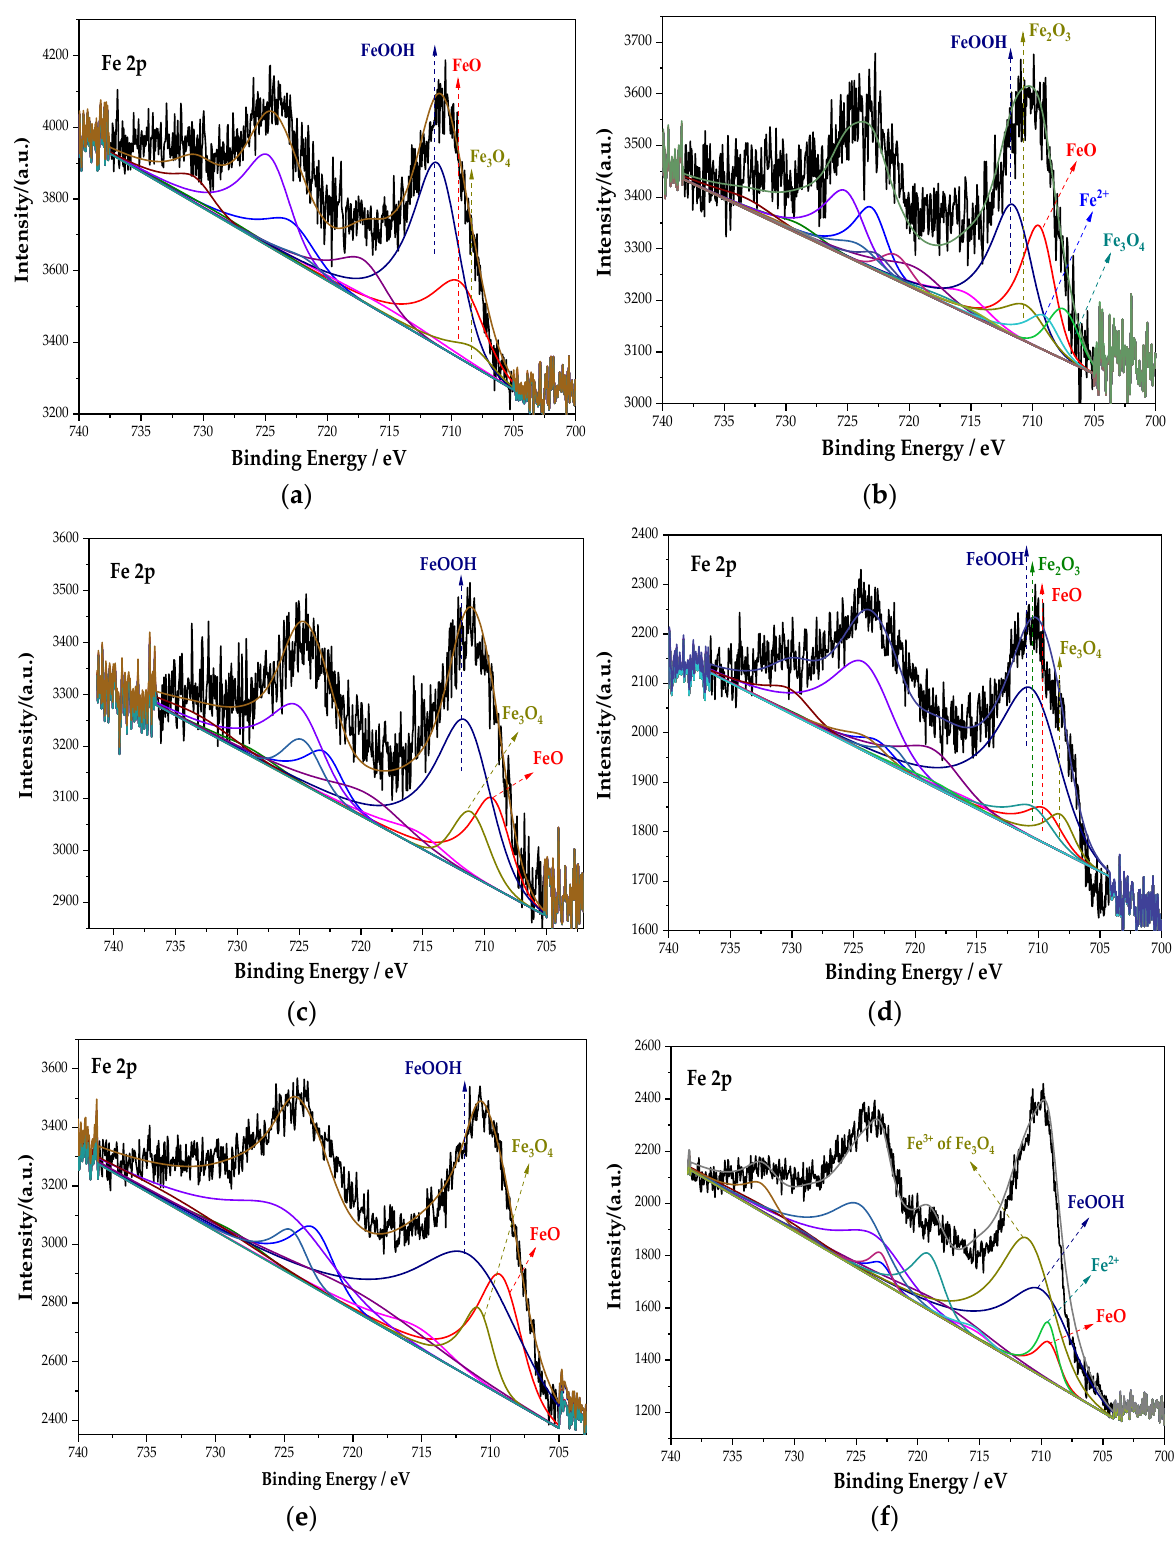
Figure 5. XPS peak spectrum of the Fe element in the passive film under the action of different rust inhibitors. ( a ) Na 2 CrO 4 group. ( b ) Na 2 MoO 4 group. ( c ) BTA group. ( d ) DMEA group. ( e ) Na 2 CrO 4 + BTA group. ( f ) Na 2 MoO 4 + BTA group. Table 4. Fitting data of the Fe element in different groups.